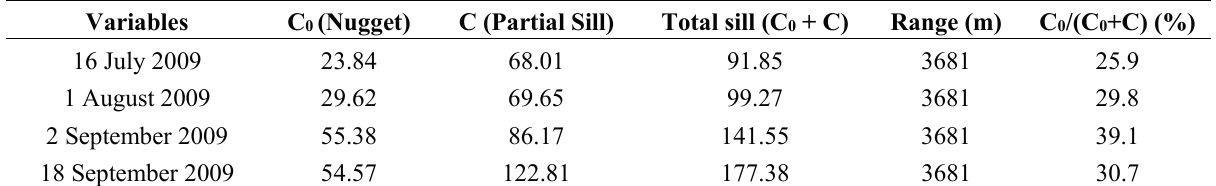
Table 1. Stable model variogram parameters for the image acquired on 16 July 2009, 1 August 2009, 2 September 2009 and 18 September 2009. Variables